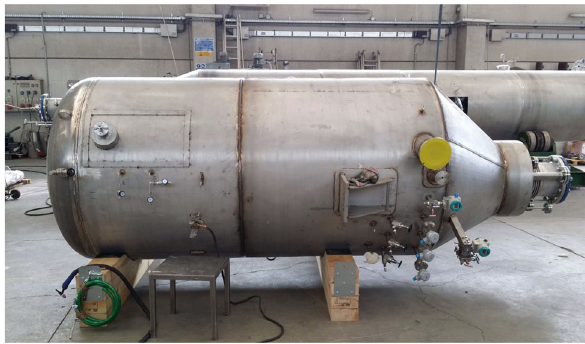
Fig. 5 The bottom module of the column